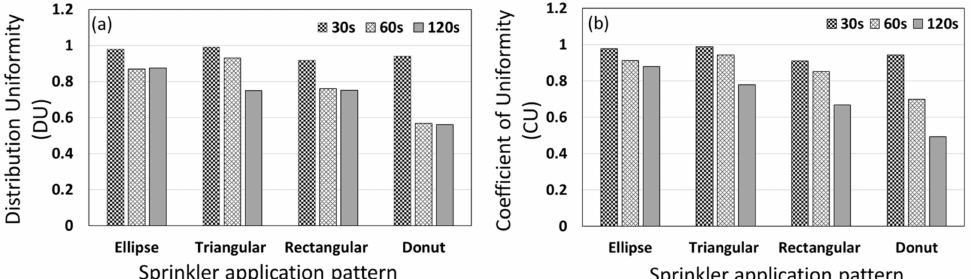
Figure 5. DU ( a ) and CU ( b ) for different cycle times (s) and application patterns.